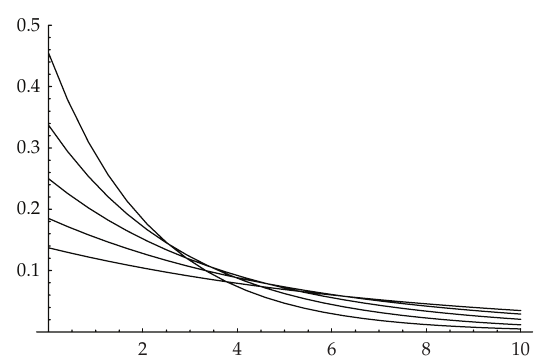
Figure 3: Density plot of exponential distribution with hazards 1/4𝑒 𝛽